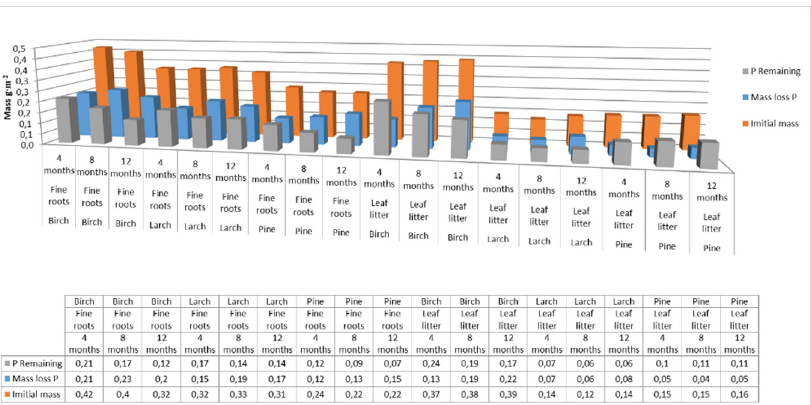
Figure 6. Phosphorus pool supplied to soils with fine roots and leaf litter at different decomposition times for different species. (Initial mass—the initial mass of phosphorus accumulated in fine roots or leaf litter at the end of the growing season; P Remaining—phosphorus accumulated in fine roots or leaf litter after 4, 8 or 12 months of decomposition; Mass loss C—loss of phosphorus from the fine roots or leaf litter after a specified decomposition time).